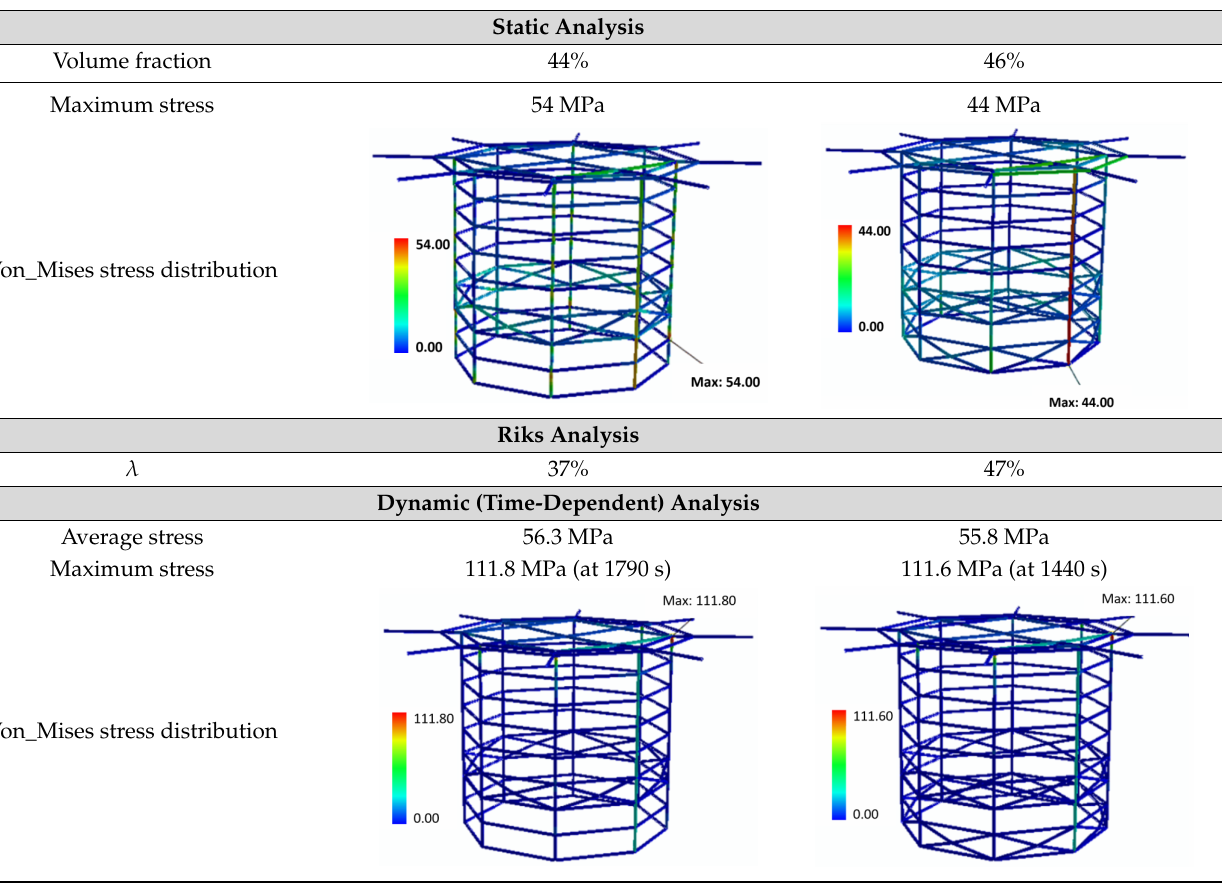
Table 5. Comparison of the results of static, Riks and dynamic analyses of the structures meeting all